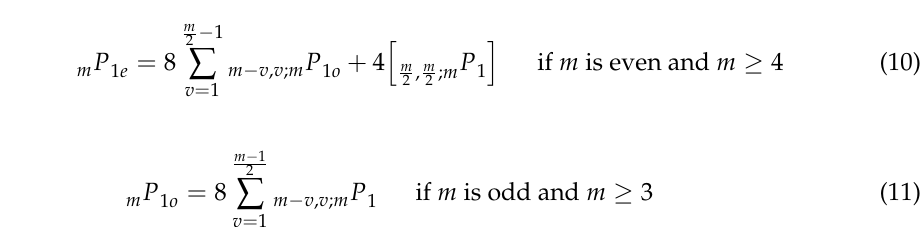
A 1 B 1 A 1 B 2